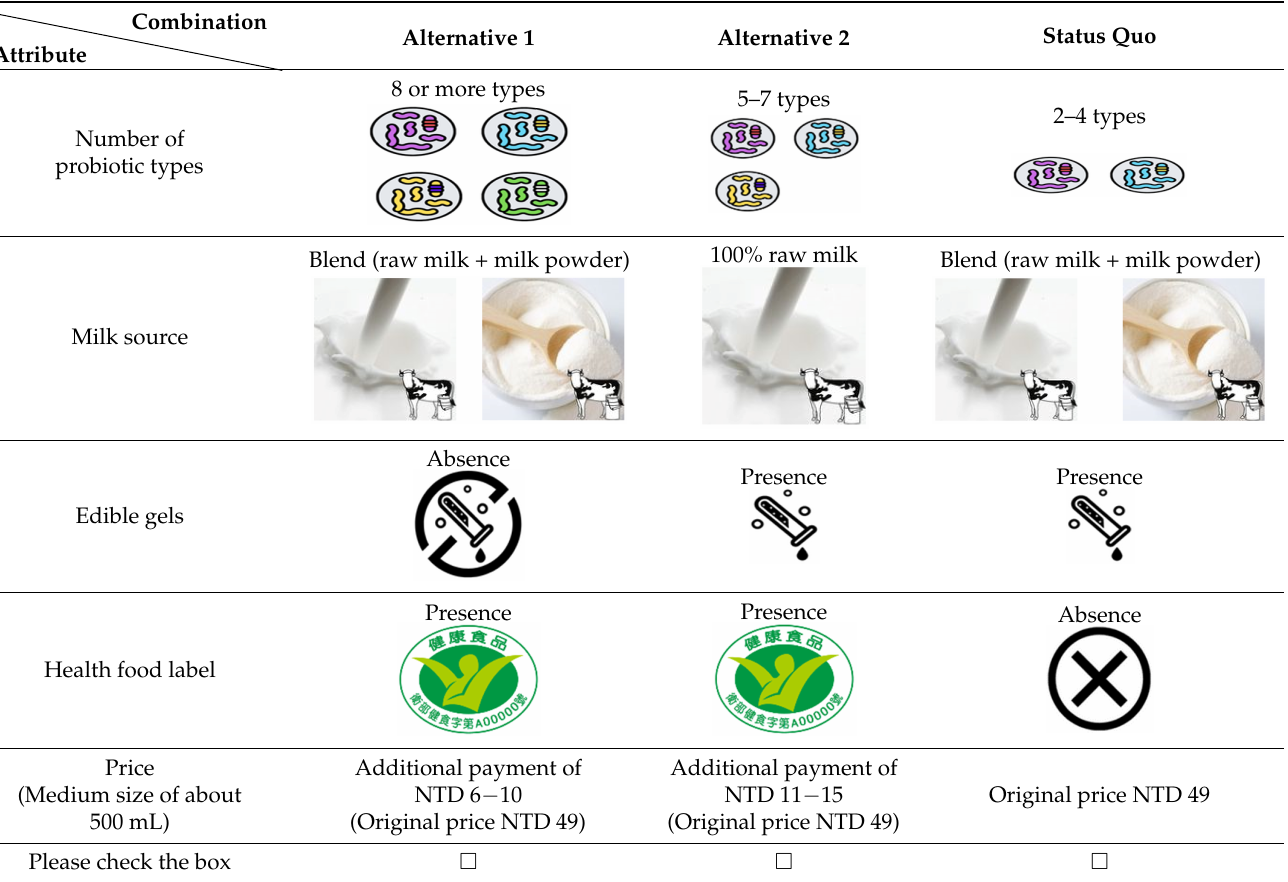
Table 2. Example of choice collection in the questionnaire